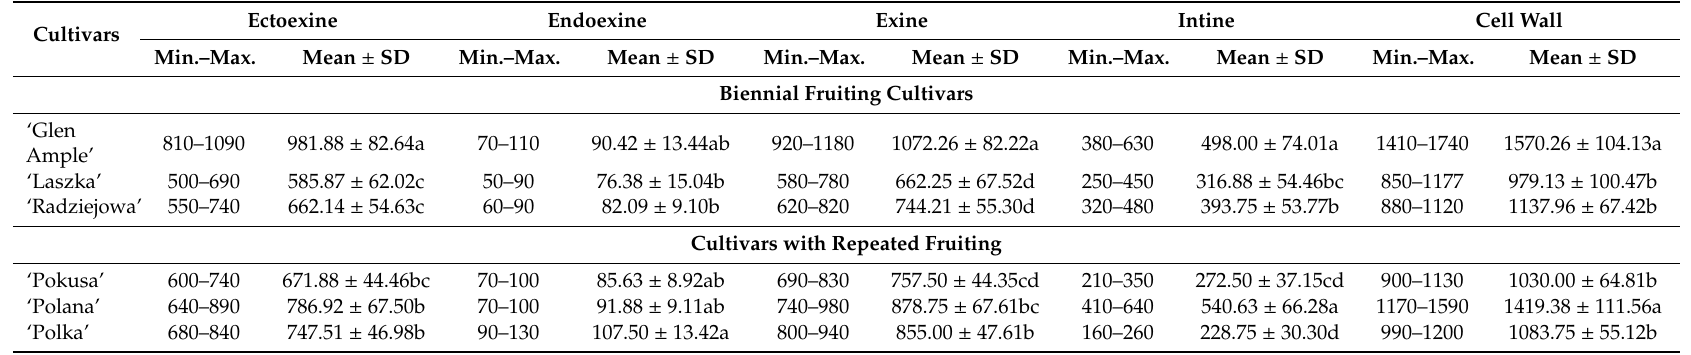
Table 5. Thickness of the ectoexine, endoexine, intine, and cell wall of pollen grains of R. idaeus cultivars